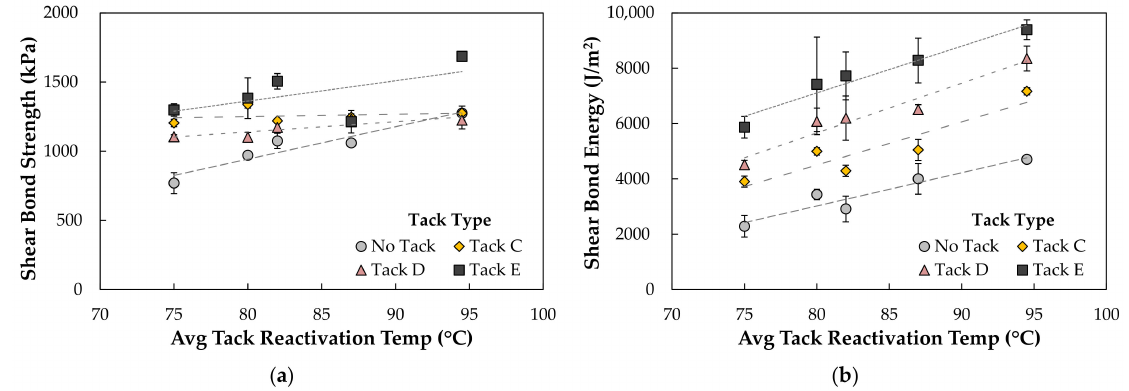
Figure 9. Effect of tack reactivation temperature on ( a ) shear bond strength and ( b ) shear bond energy for laboratory samples with different